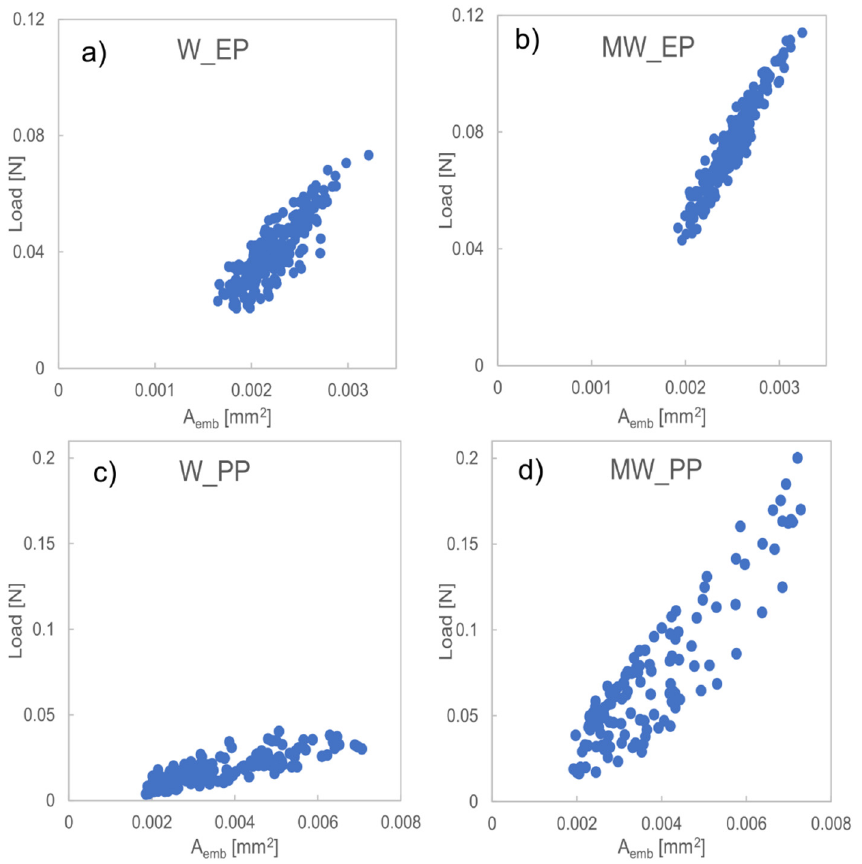
Figure 4. Load vs. embedded area for all measured droplets for ( a ) W_EP, ( b ) MW_EP, ( c ) W_PP, and ( d ) MW_PP.